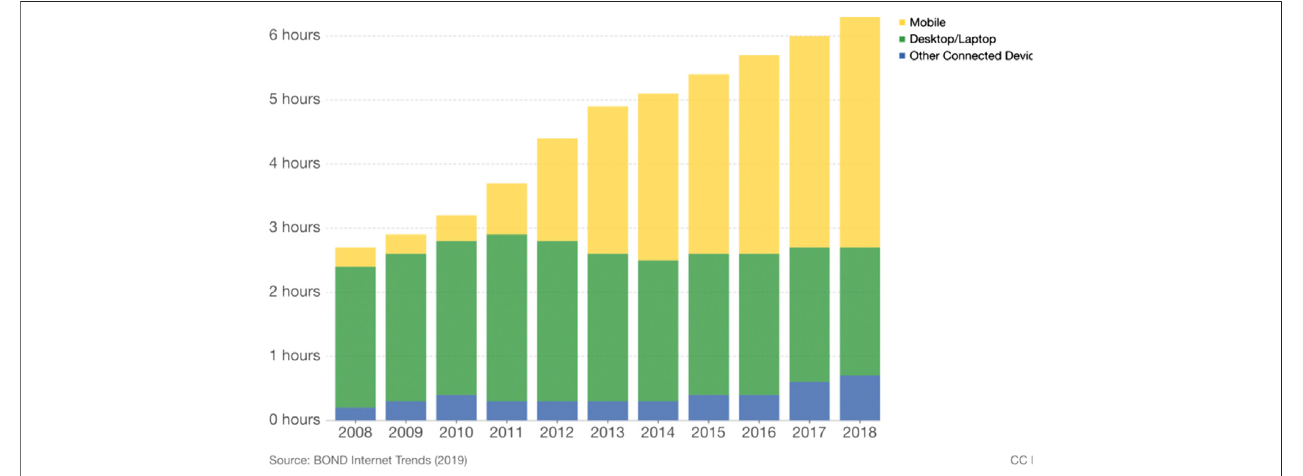
FIGURE 1 | Max Roser, Hannah Ritchie, and Esteban Ortiz-Ospina (2020) - Internet . Published online at OurWorldInData.org. Retrieved from: https://